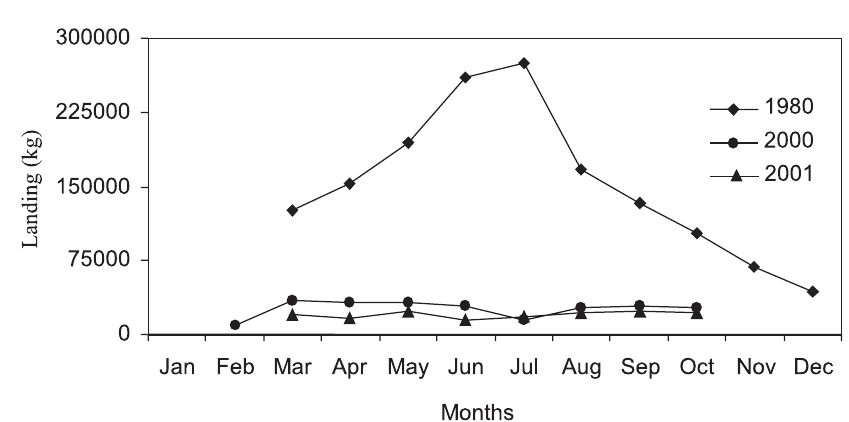
Fig. 8. Comparison of monthly landed catch in 1980 and the current data for the rio Cuiabá